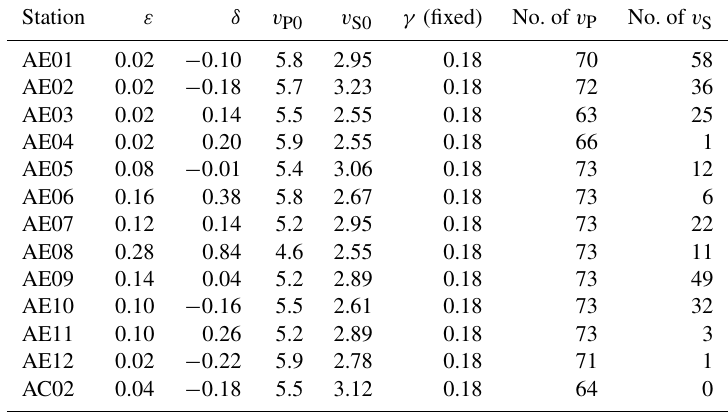
Table 5. Thomsen parameters ( ε , δ and γ ) characterising elastic anisotropy of the rock mass derived from fitting all active seismic UT measurements per seismic station. The last two columns give the numbers of measurement points for v P and v S , from which the parameters were